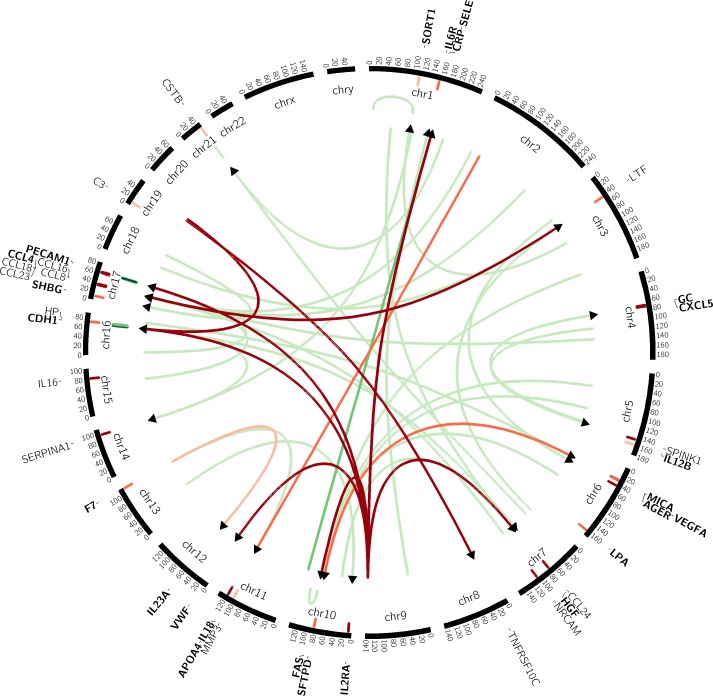
Circos plot showing distant (trans) pQTLs and their relationships to eQTL SNPs.The arrows in the inner circle represent pQTL SNPs significantly associated (beginning of arrow) with biomarker (end of arrow). Biomarker abbreviations (see text for full list) are shown on the outer ring. Local (cis) pQTL SNPs are shown as hash marks adjacent to biomarker gene location. The color of represents significance of association. Red lines are associations between genes. The thinnest, darkest red lines signify associations with significance of P = 10−12, and the lines become slightly thicker and darker at the significance levels of P = 10−10 and P = 10−8. The green lines signify eQTL associations. The cutoffs for line thickness and darkness for the green lines are P = 10−7 and P = 10−6. The only eQTL association with significance P < 10−8 were local, near the HP and PECAM1 genes.